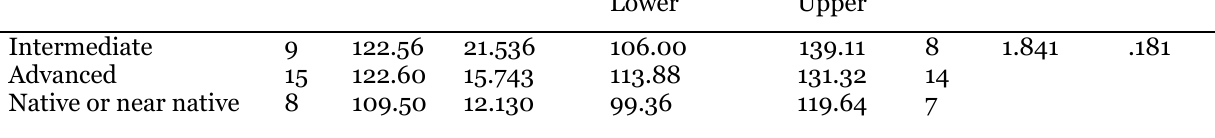
Difference in Strategy Use among Learners of Different Foreign Language Proficiencies ANOVA N Mean Std. 95% confidence Deviation interval of the difference